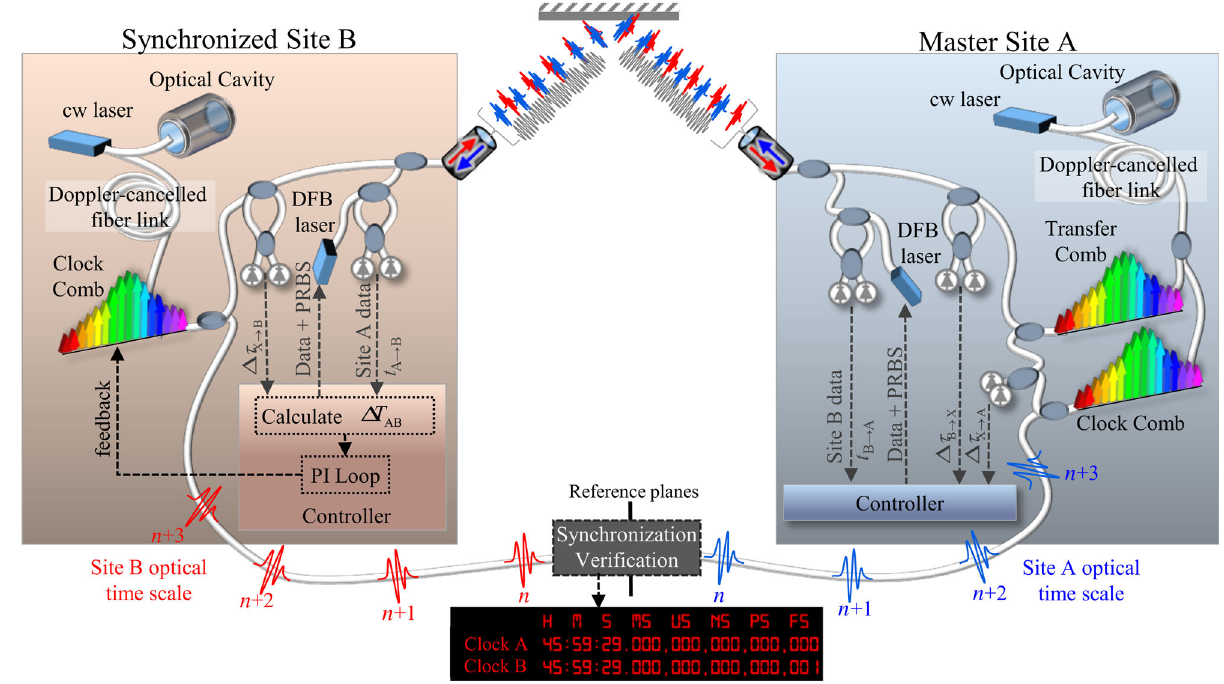
FIG. 2. Setup for the generation and synchronization of two optical time scales, one located at site A and one at site B, via optical two- way time-frequency transfer over a turbulent air path. The optical time scale from each site is defined by the arrival of pulses from the clock comb at a specified reference plane. For example, the n th pulse from each site arrives at the reference plane at the time shown in the lower display, while the ð n þ 1 Þ st pulse arrives at a time 1 =f r later. In the setup here, the two colocated clocks have a common reference plane to allow for out-of-loop synchronization verification. The timing and data exchange between the two sites occurs only over the free-space path shown in the upper part of the figure, and mimics a point-to-point link. DFB laser, distributed feedback laser and phase modulator; PI Loop, proportional-integral loop; symbols, see